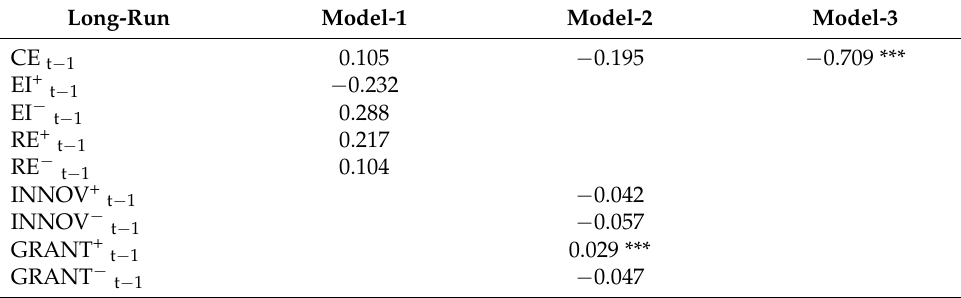
Table 7. Nonlinear ARDL